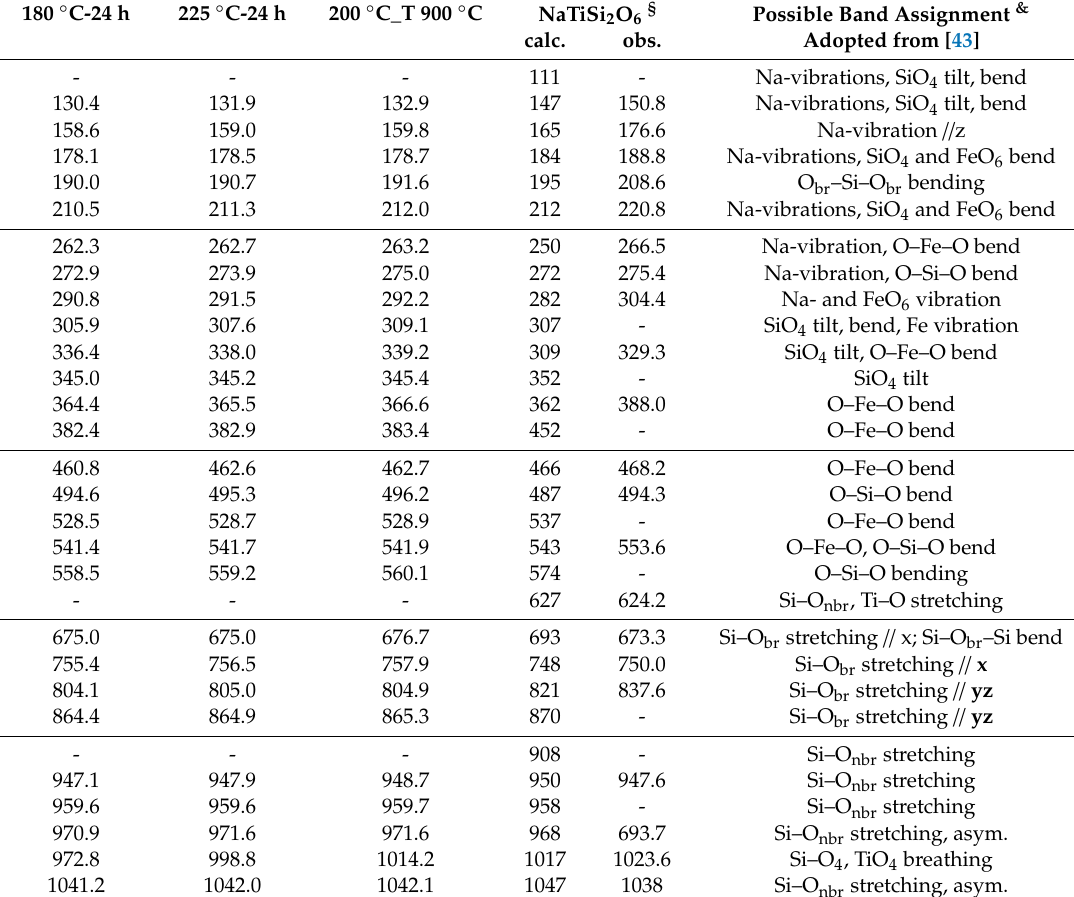
Table 3. Fitted band positions (given in cm − 1 ) in synthetic aegirine, obtained at di ff erent temperatures, compared to the Raman band positions in C 2 / c NaTiSi 2 O 6 .